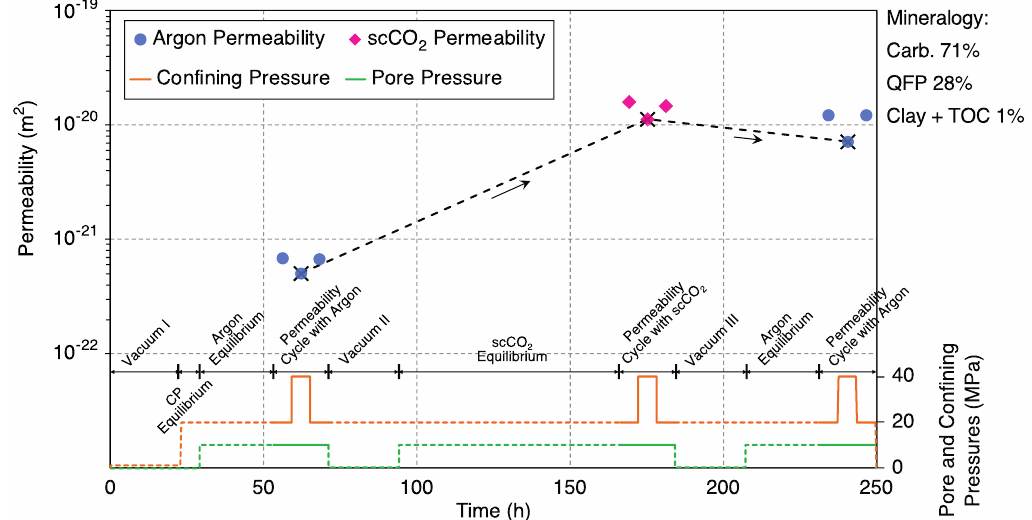
Figure 4. Permeability changes for sample 2-1H.